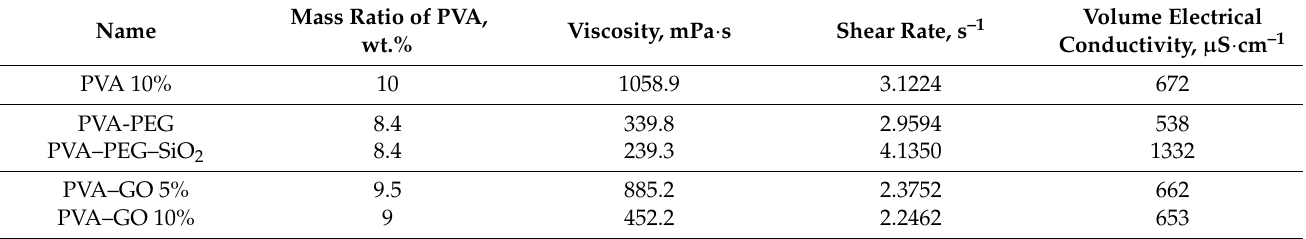
Table 2. The measurements of